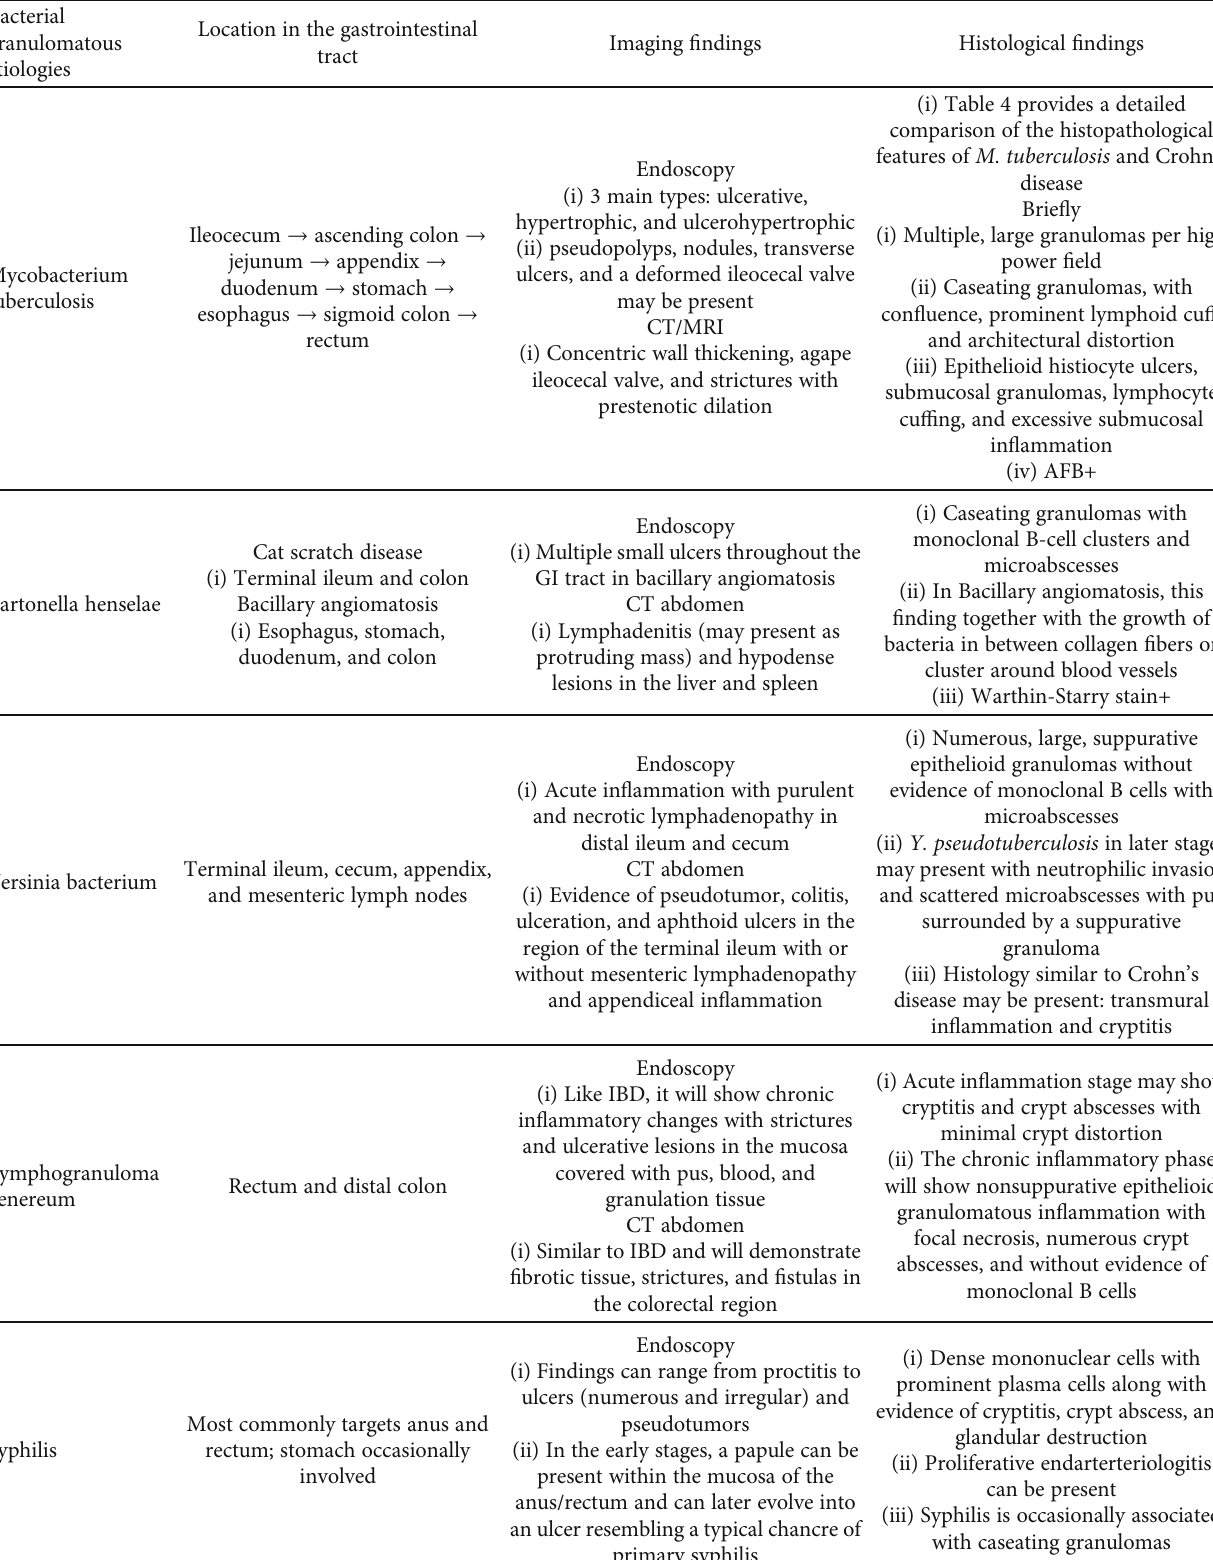
Table 1: Comparison of imaging and microscopic fi ndings together with regions of the gastrointestinal tract a ff ected by bacterial causes of granulomatous